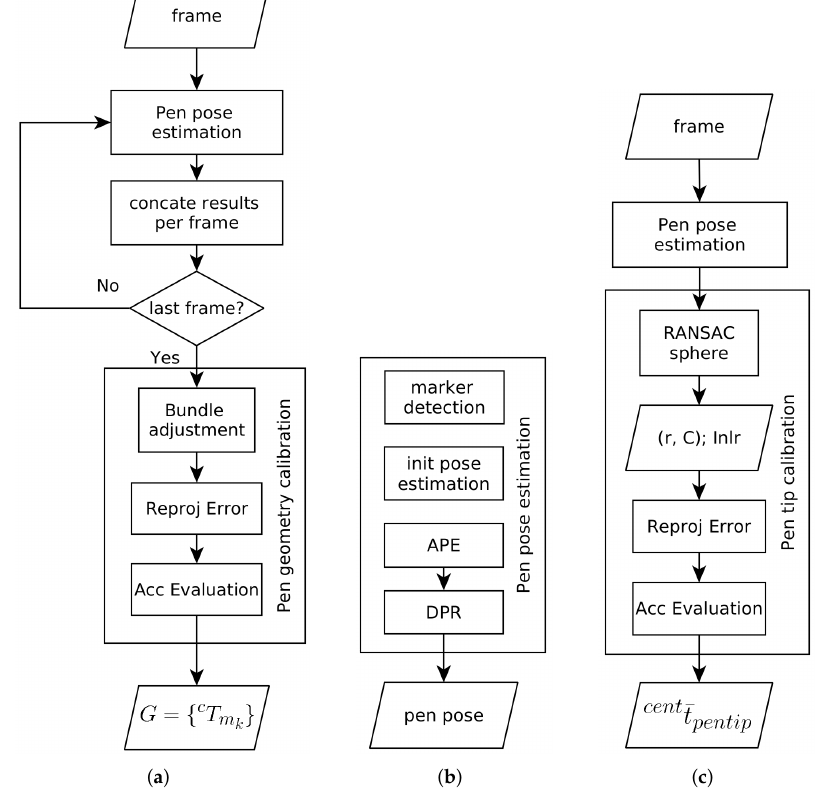
Figure 7. System operation flowchart. ( a ) Geometry calibration. ( b ) Pen pose estimation module. ( c ) Pentip